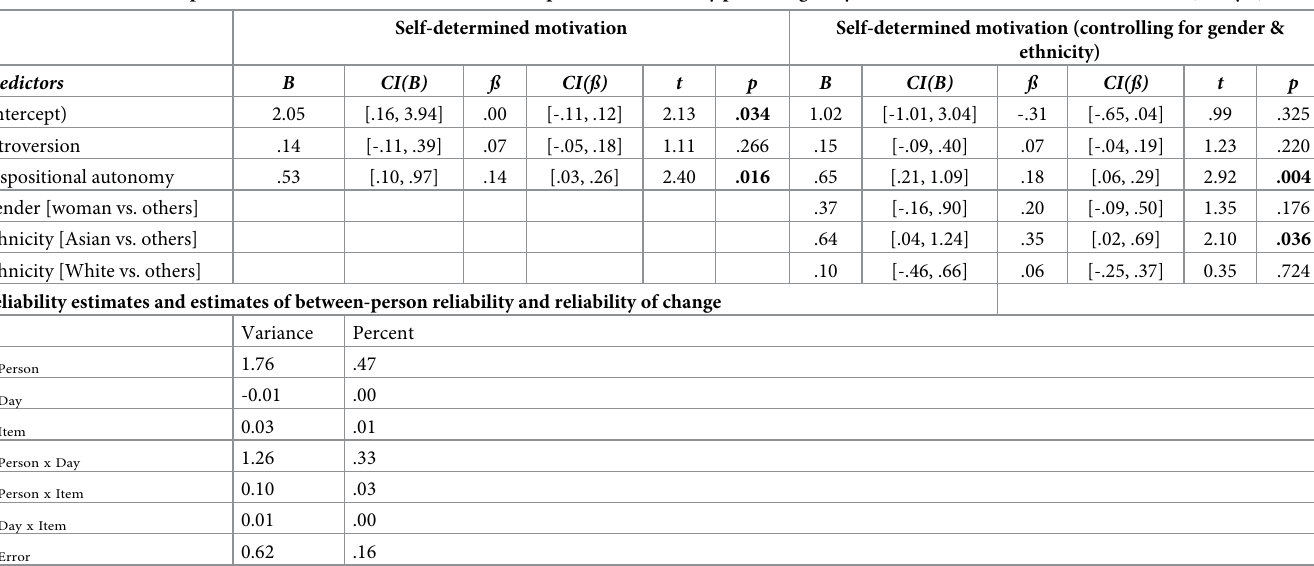
Table 1. Random-intercept models that include introversion and dispositional autonomy predicting daily self-determined motivation for solitude (Study 1).